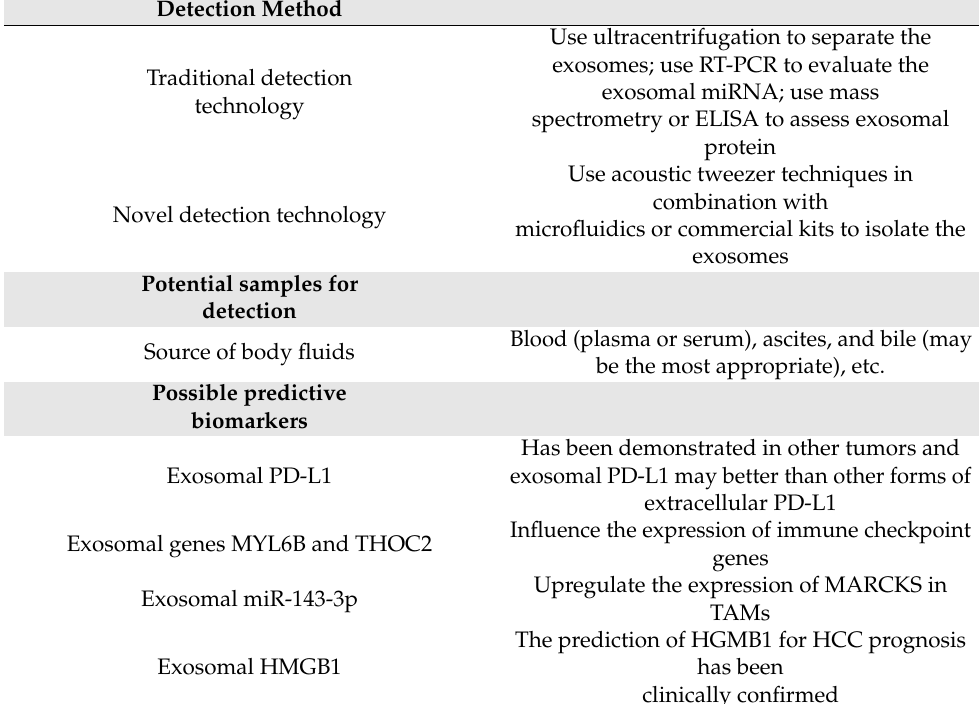
Table 2. Exosomes in predicting the efficacy of